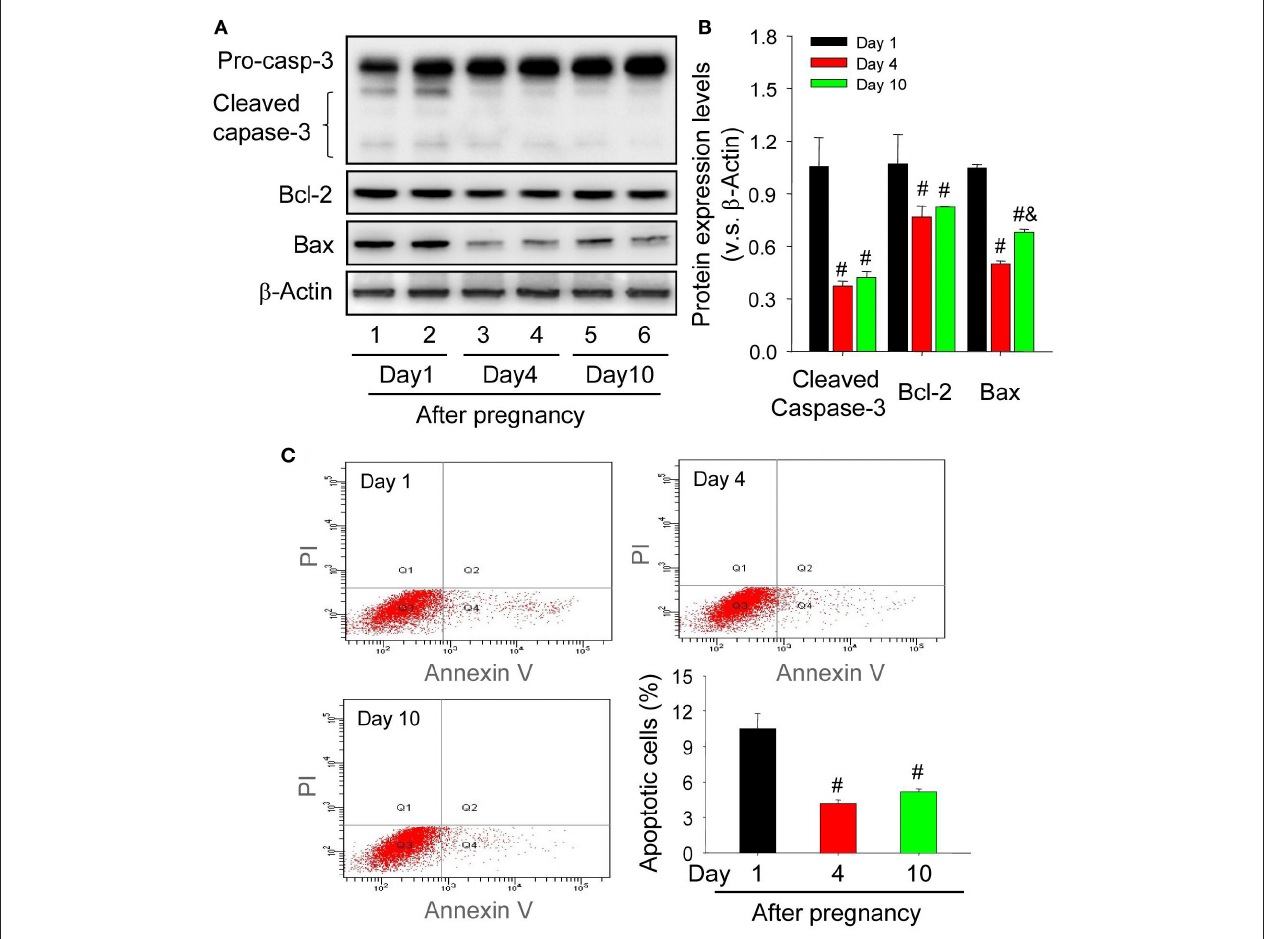
FIGURE 5 | Changes of luteal cell apoptosis levels during the development of corpus luteum. (A) Expression changes of caspase-3, Bcl-2, and Bax proteins in luteal cells during the development of corpus luteum (from Day 1 to 10). (B) Summarized intensities of cleaved caspase-3, Bcl-2, and Bax bloting normalized to the control (Day 1). (C) The representative images of Annexin V-PI staining by flow cytometry and the quantitative analysis of luteal cell apoptosis during the development of corpus luteum. The luteal cells were obtained from the pregnant corpus luteum on Day 1, 4, and 10. Each value represents the mean ± SE. One-way analysis of variance (ANOVA) was used to analyze the data, followed by a Tukey’s multiple range test. n = 6. # P < 0.05, vs. the group in black. & P < 0.05, vs. the group in